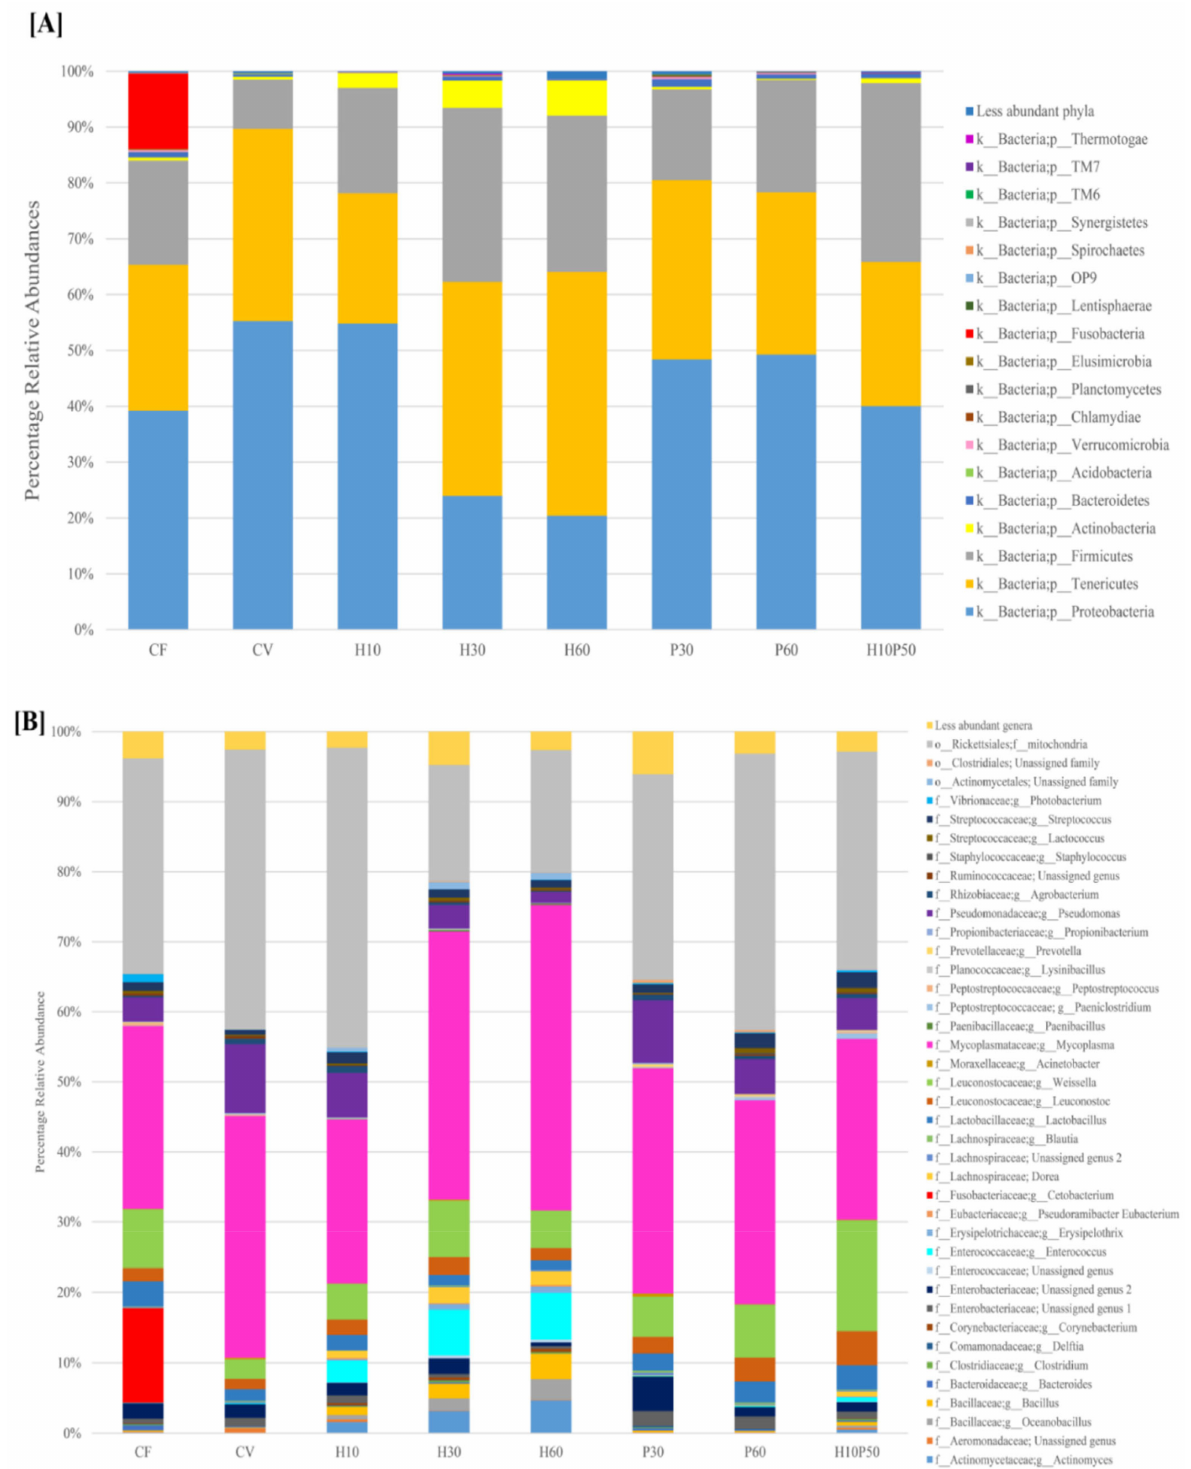
Figure 2. Percentage relative abundance of phyla ( A ) and genera ( B ) in the intestinal contents. Less abundant phyla or genera include bacteria with a relative abundance less than 0.01% in fewer than 25% of